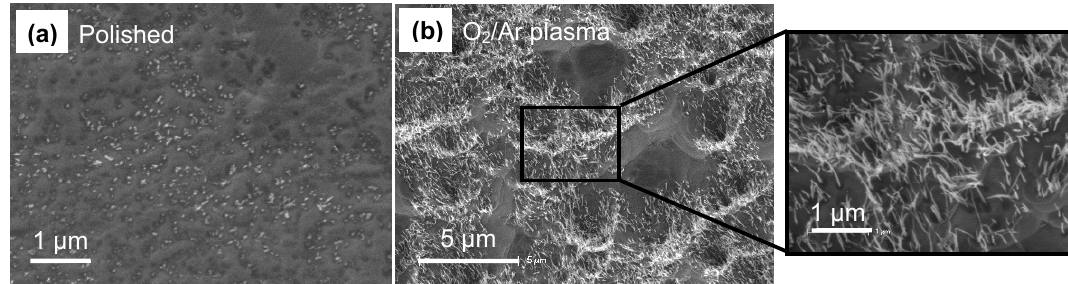
Figure 15. SEM images showing the CNT membrane surface after (a) polishing and (b) a 4 hour plasma treatment with a mixture of 30% O treatments were performed at a pressure of 0.6 mbar and power of 80W in a Pico PC system from Diener